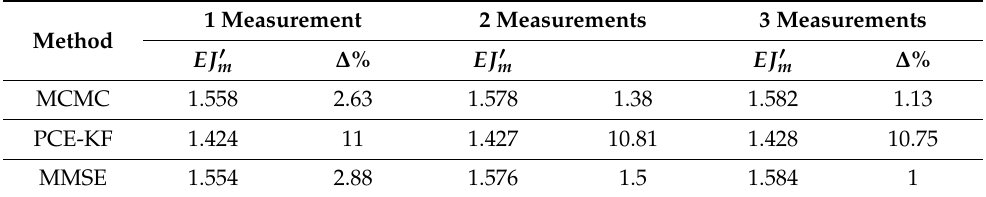
Table 5. Performance of the different updating procedures: comparison of posterior mode EJ (cid:48) m and EJ true = m + 3 s = 1.6.